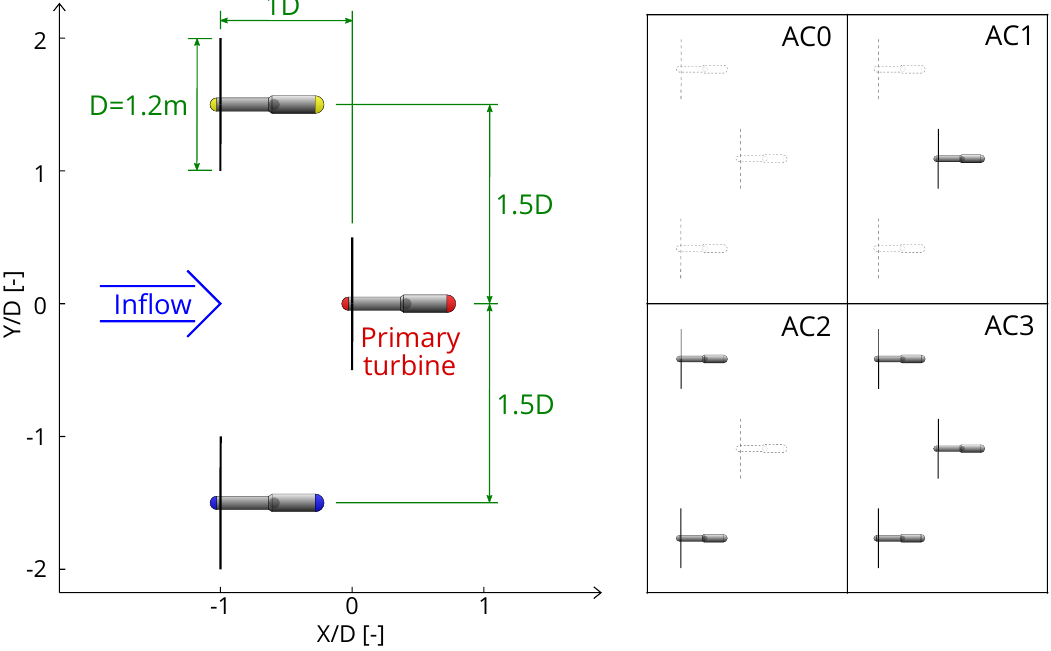
Figure 3. ( left ) Three turbine array layout, and ( right ) four configurations tested: AC0 empty tank, AC1 primary turbine only, AC2 upstream turbines only, and AC3 full